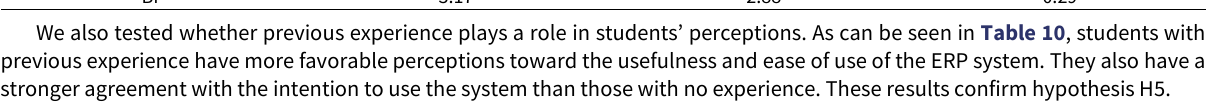
Table 10. Average values considering previous experience - Time 1 and 2